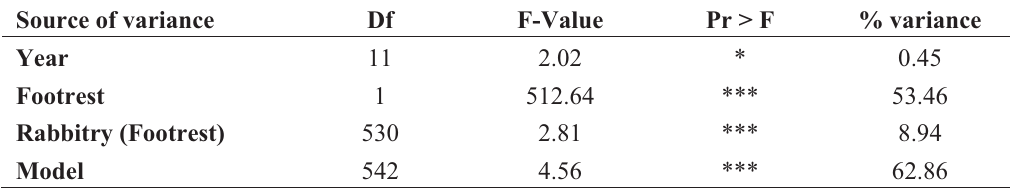
Table 2. The ANOVA for the Prevalence of Sore Hocks in rabbit females.